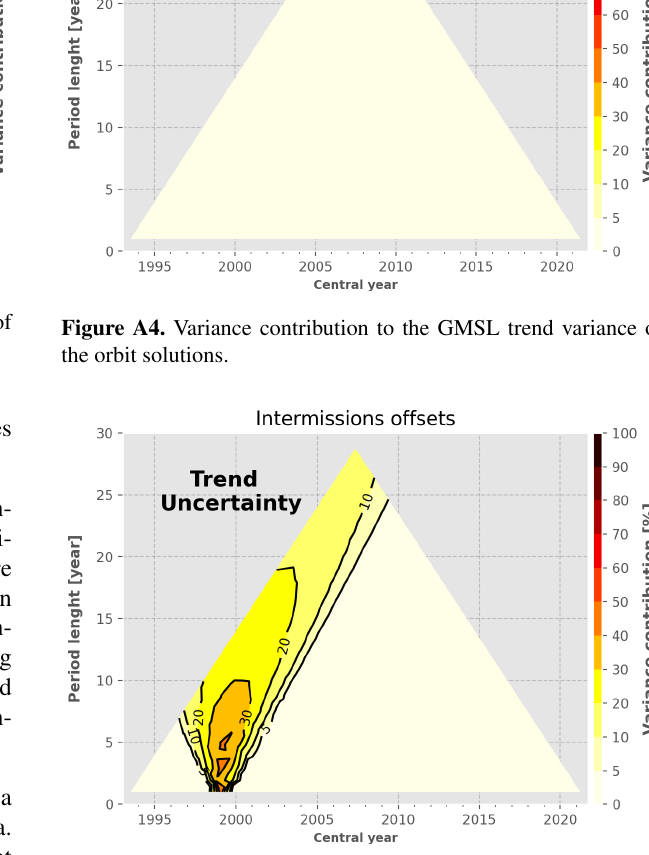
Figure A5. Variance contribution to the GMSL trend variance of the intermission offsets.